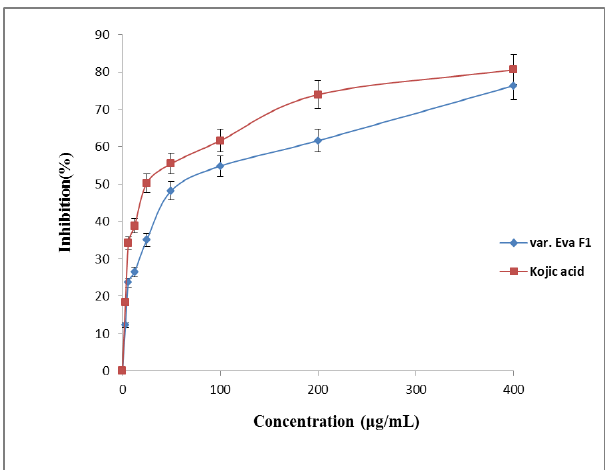
Figure 2: The percentage inhibition curve of L. esculentum (var. Eva F1) and kojic acid.